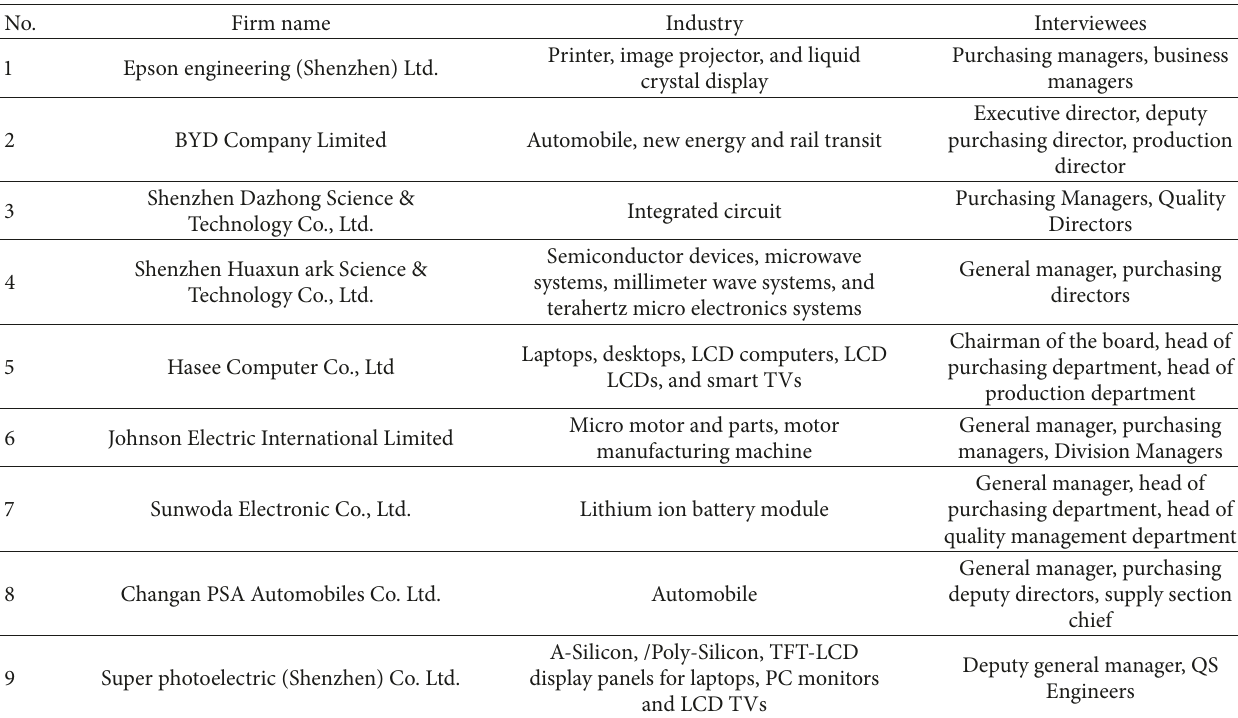
Table 5: Basic information of enterprises